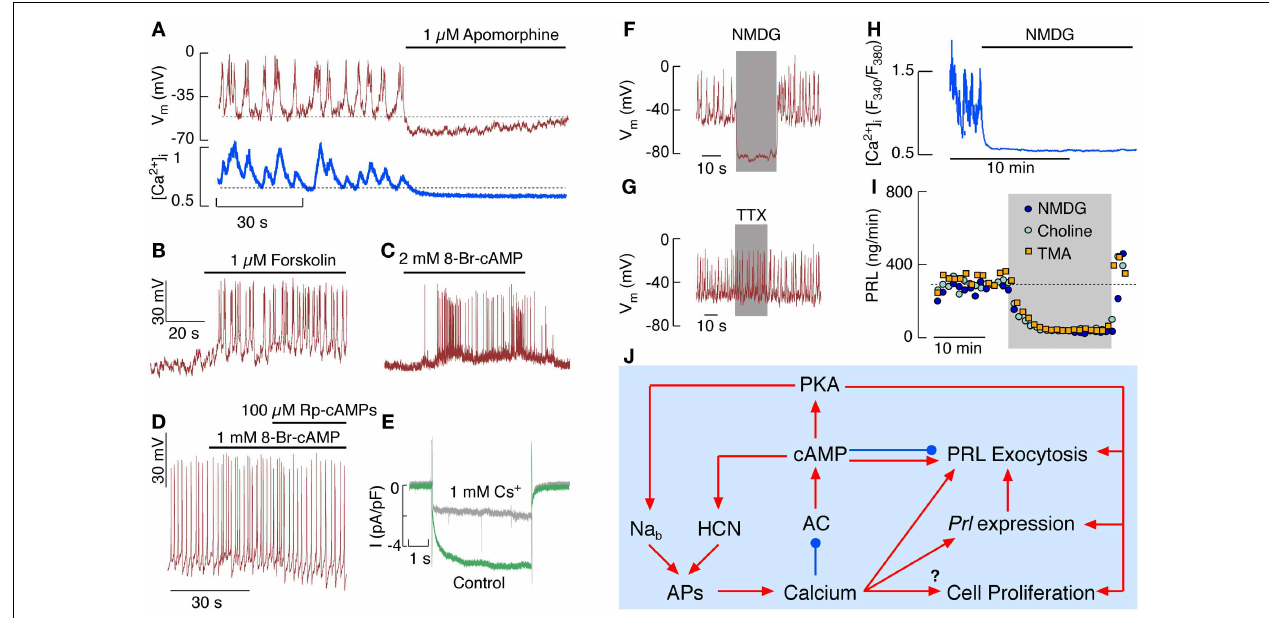
absence (green) of 1mM Cs + , an inhibitor of HCN channels. (F,G) Effects of complete replacement of bath Na + with NMDG (F) and addition of tetrodotoxin (TTX) (G) on electrical activity in lactotrophs. (H) Effects of complete replacement of bath Na + with NMDG on spontaneous Ca 2 + signaling in lactotrophs. (I) Effects of complete replacement of bath Na + with NMDG, choline chloride, andTMA on basal PRL release. (J) Schematic representation of effects of intracellular Ca 2 + and cAMP on lactotroph